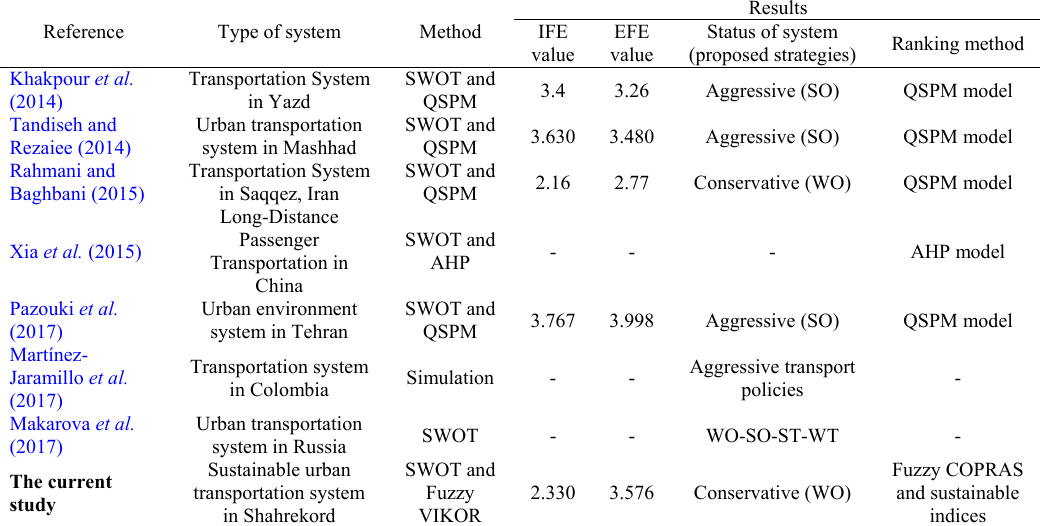
Table 10: Qualitative comparison of the concerned researches